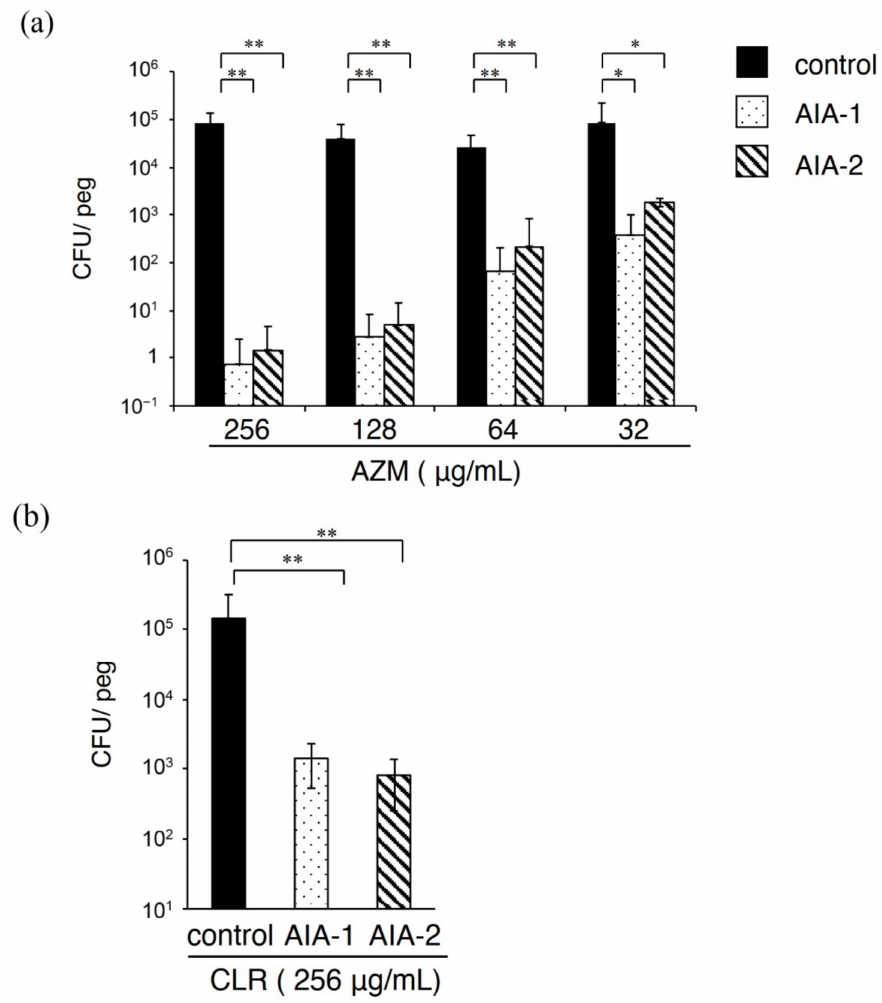
Figure 3. Efficacy of AIA-1 and -2 against PAO1 biofilms. Killing assay for biofilm cells using ( a ) 256, 128, 64, and 32 µ g/mL azithromycin with 32 µ g/mL AIA-1 or -2 ( b ) 256 µ g/mL clarithromycin with 32 µ g/mL AIA-1 or -2. The number of CFU per peg was calculated. * p < 0.05, ** p < 0.01 (Student’s t -test). Error bars, SDs for eight